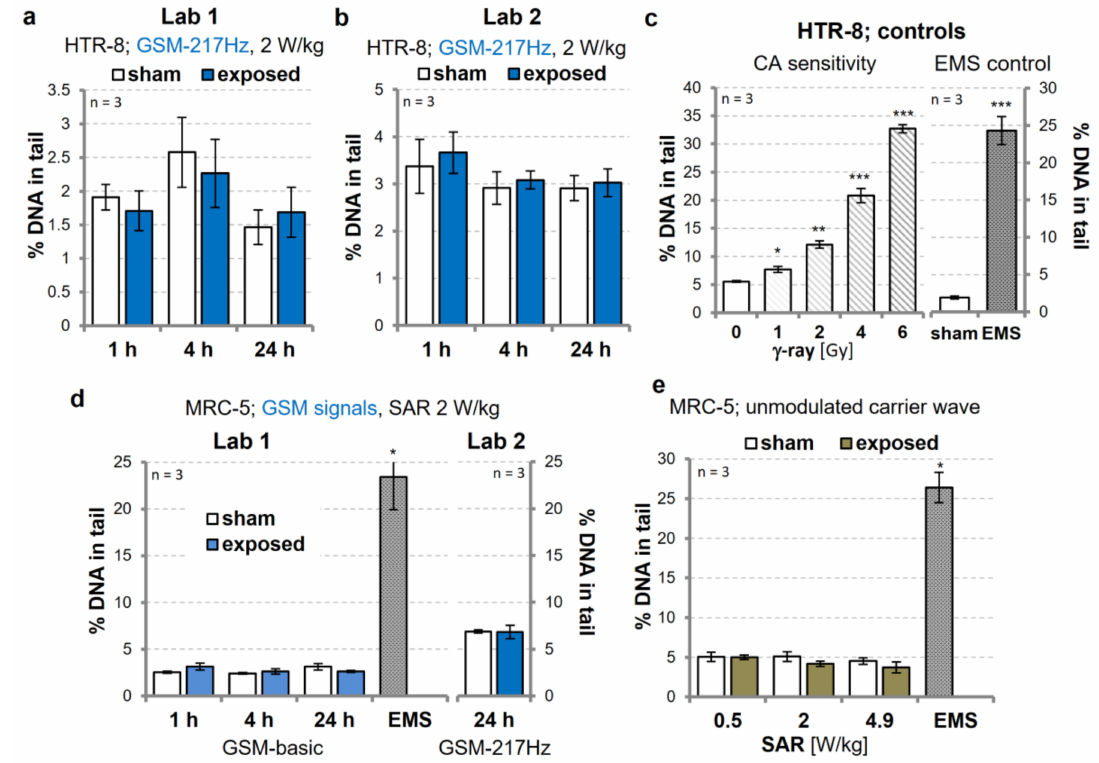
Figure 1. Global System for Mobile Communications (GSM)-modulated signals do not induce DNA damage in human cells. Immortalized HTR-8 / SVneo (HTR-8) trophoblasts ( a – c ) and primary MRC-5 lung fibroblasts ( d , e ) were intermittently exposed (5 / 10 min on / o ff ) to GSM-217Hz ( a , b , d right panel), a GSM-basic signal ( d left panel), or an unmodulated RF-EMF ( e , carrier wave), as indicated. Alkaline Comet assays (CAs) were independently executed in two laboratories, according to their standard protocols, and compared to sham-exposed control samples. ( c ) As sensitivity and positive controls, cells were irradiated with increasing doses of γ -ray or treated with 0.5 µ L / mL of ethyl methanesulfonate (EMS) for 1 h, concomitant to RF-EMF exposure. Data represent arithmetic means ± SEM of three independent experiments. Asterisks indicate significance levels of Student’s t -test comparing GSM-exposed and EMS-treated cells with sham-exposed samples: * p < 0.05; ** p < 0.01; *** p <